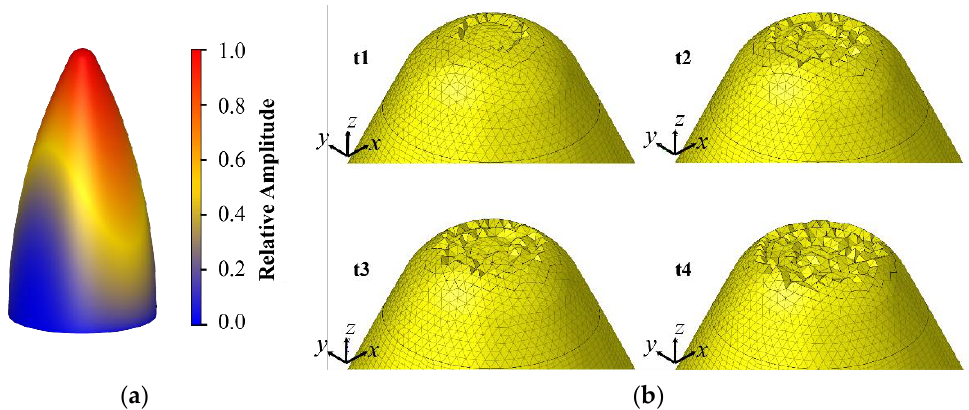
Figure 4. Distribution of permittivity and defection on the radome for simulation of ablation process: ( a ) Relative amplitude of permittivity of the radome; ( b ) three-dimensional views of defection on the radome at four ablating moments.